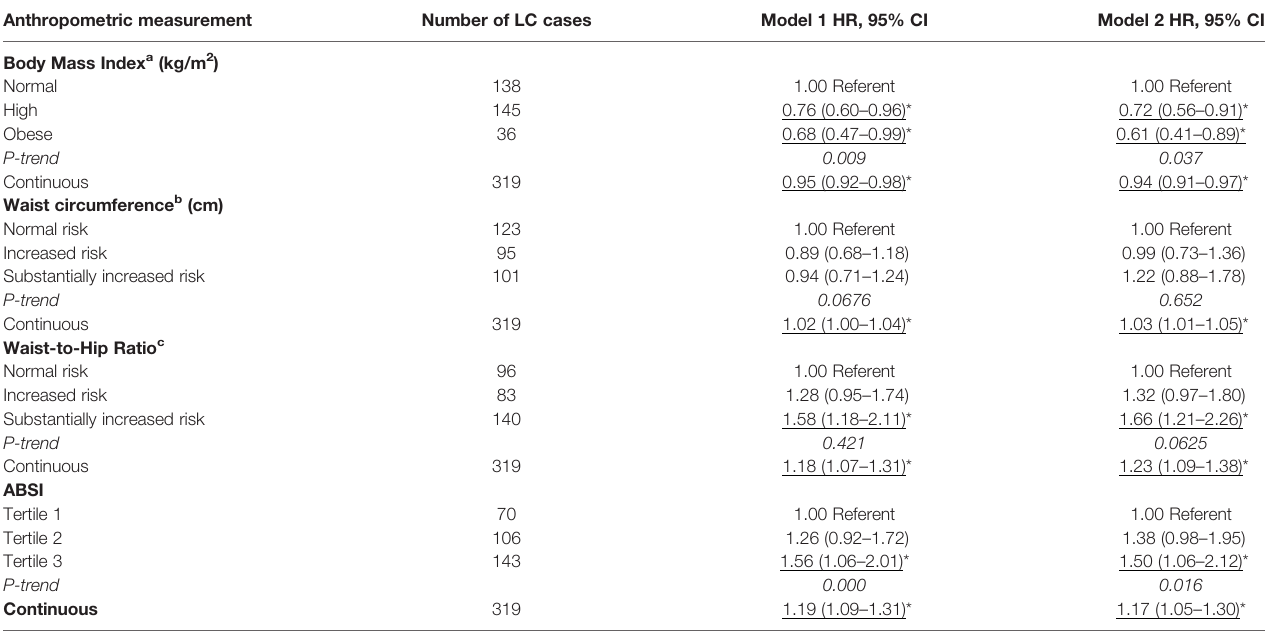
TABLE 2 | Hazard ratio ’ s (95% CI) for the association between BMI (kg/m 2 ), WC (cm), WHR, and ABSI with the risk of lung